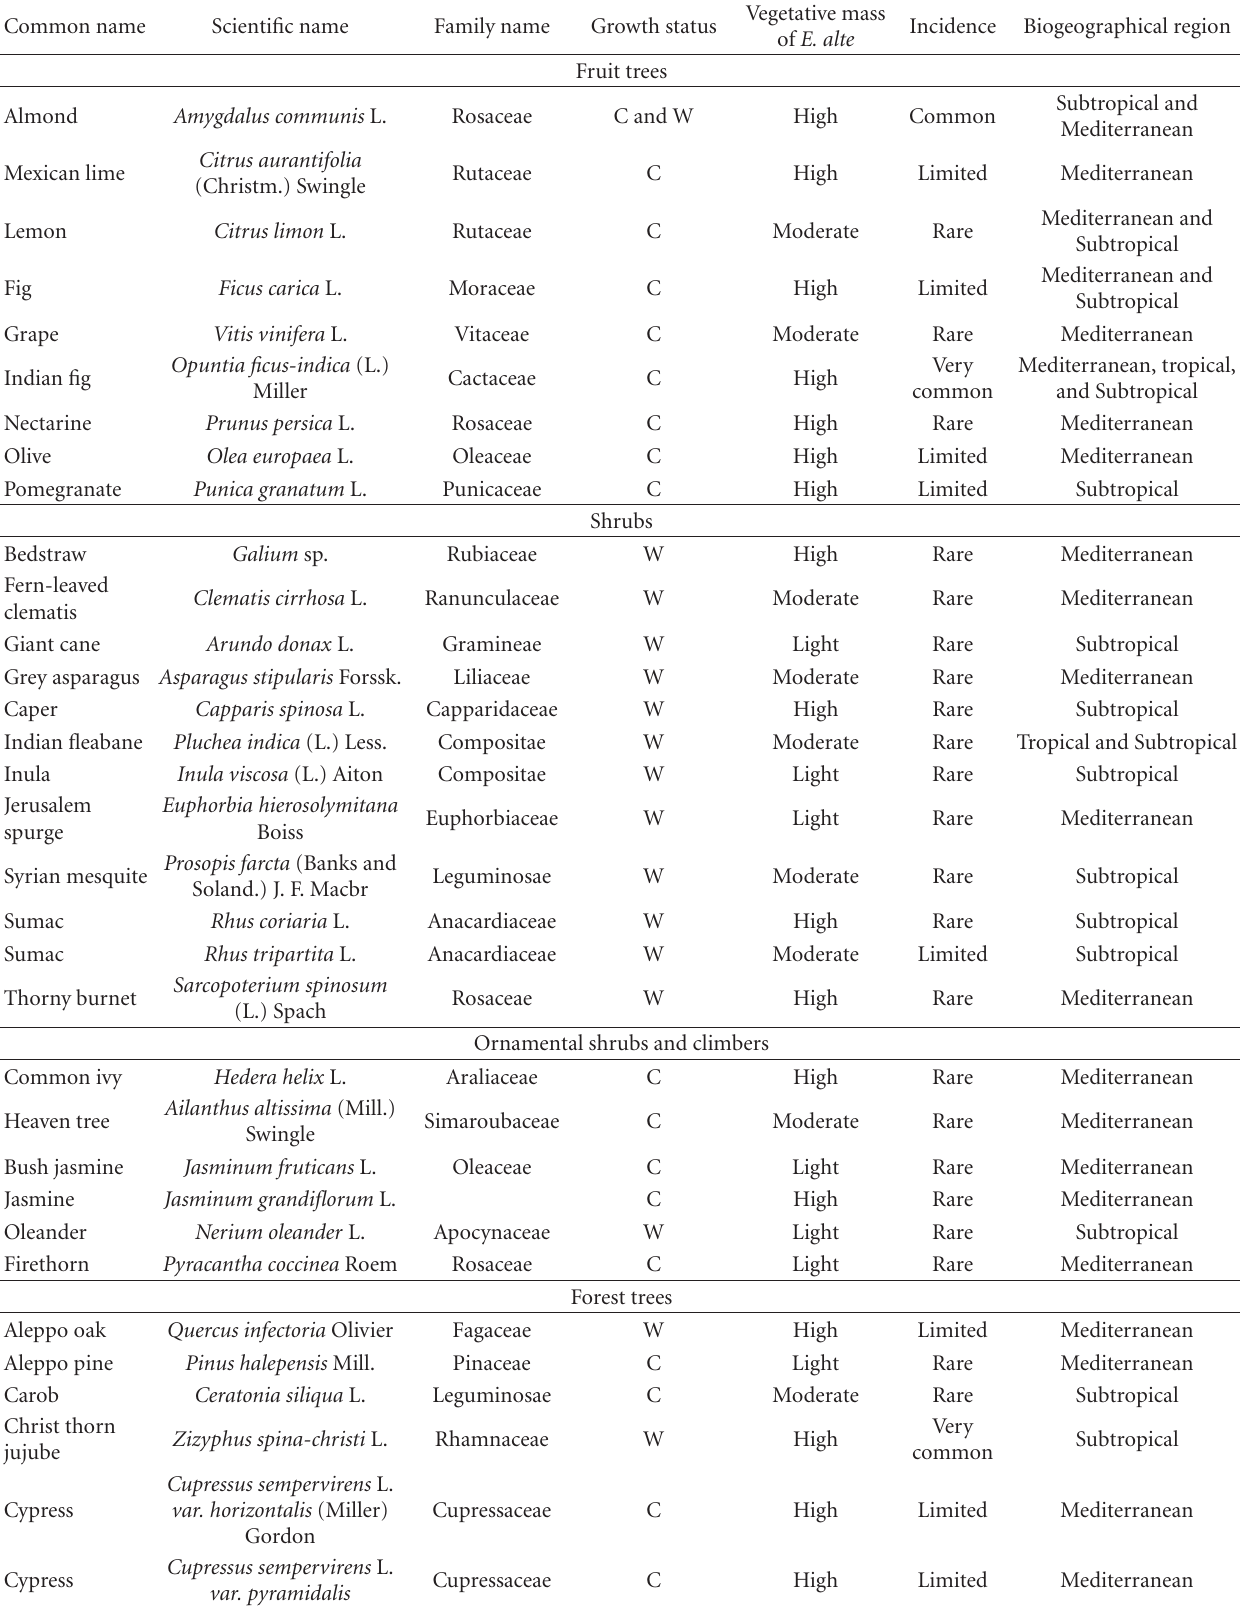
Table 2: Common, scientific, and family names, growth form, vegetative mass, incidence, and biogeographical regions of plant species attacked by E. alte in Jordan for the period